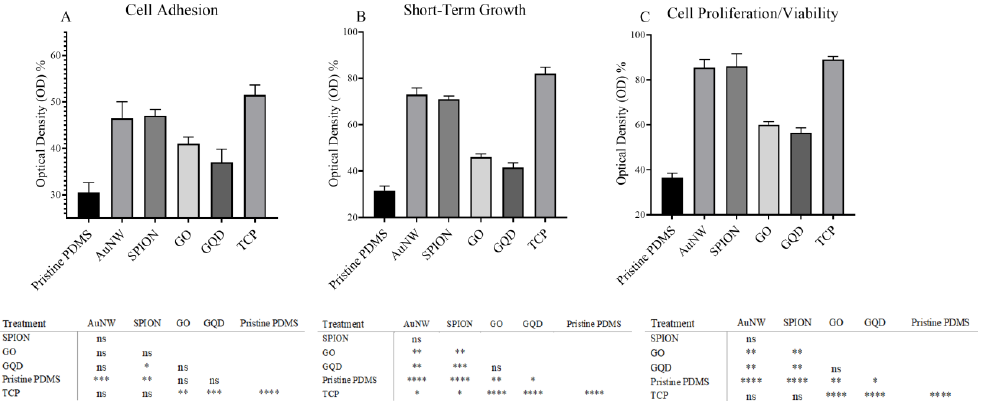
Figure 4. Cell adhesion ( A ) short-term growth ( B ) and cell proliferation ( C ) of substrates and the corresponding significance table is presented. ns, *, **, *** and ****: non-significant, significant at 5%, 1%, 0.1%, and 0.01% levels of probability, respectively. TCP is tissue culture plate.